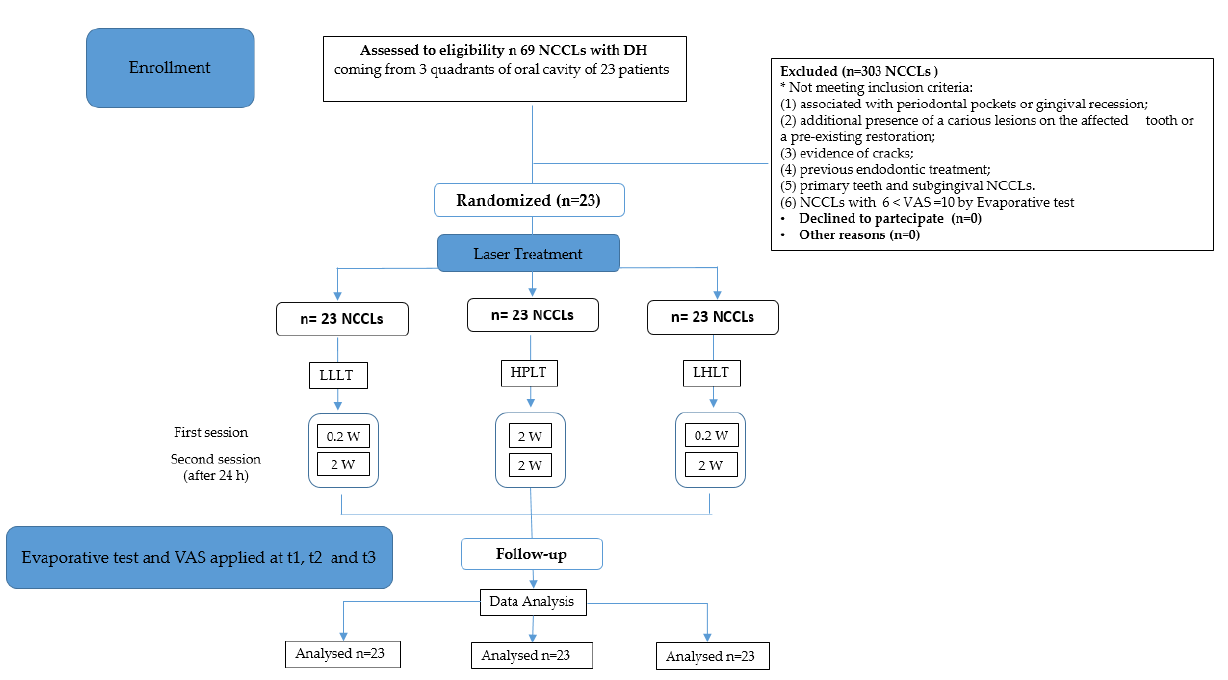
Figure 2. Flow diagram showing the study project.